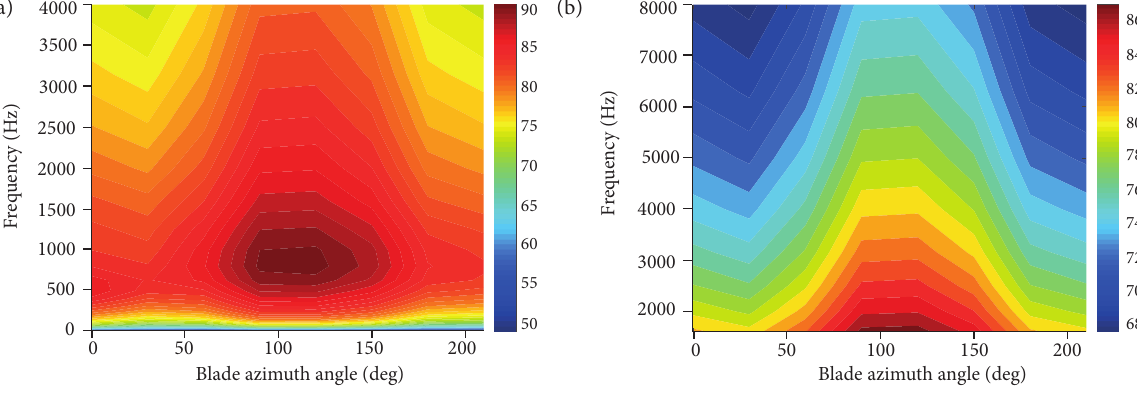
Figure 3. Computed noise map of single source (TBL-TE) sound power level (dB) of an isolated blade segment 75 %R, for single blade at wind speed of 8 m/s (a) between 20 and 4 kHz; and (b) between 1.6 and 8 kHz for blade azimuth positions 0° to